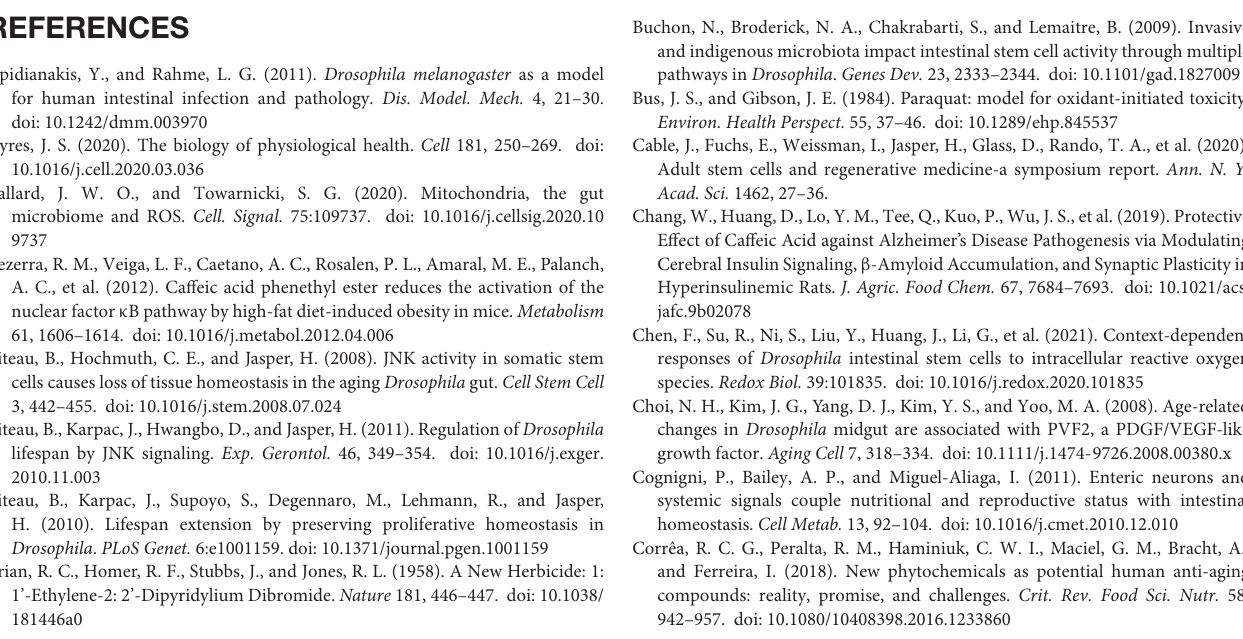
Supplementary Figure 2 | Caffeic acid prevents ISC aging via antioxidant ability, related to Figure 5 . (A,B) Immunofluorescence images of the R4 region of